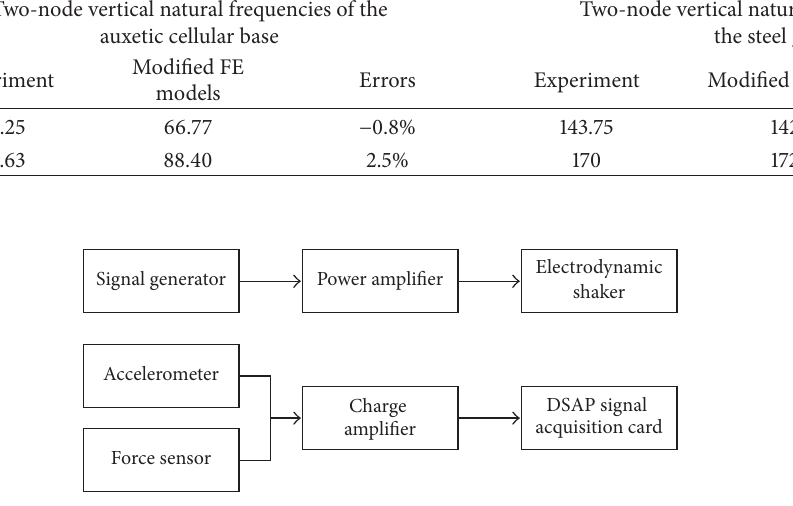
Figure 26: Block diagram of the excited and measured analysis system.